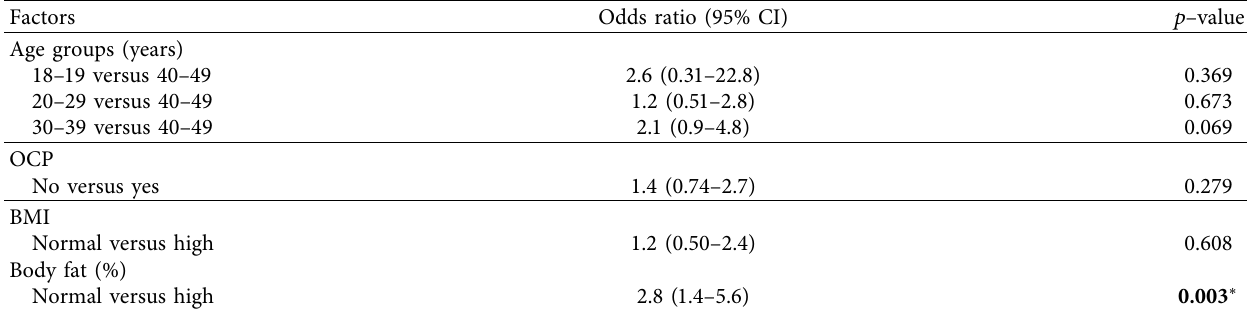
Table 2: The table depicts the logistic regression analysis for likelihood of chronic migraine ( n � 62), in patients of episodic migraine ( n � 106) having high body fat percentage, other covariates being adjusted.